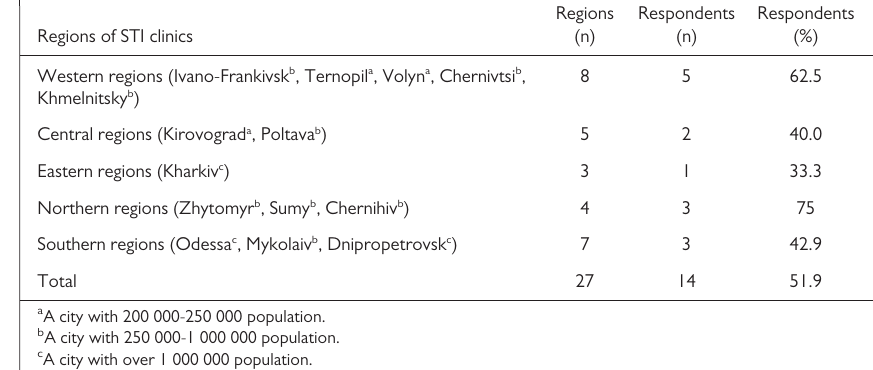
Table 1. Responding Rate of Regional STI Clinics Participated in the Survey Regarding the Diagnostics of Gonorrhoea in Ukraine Regions of STI